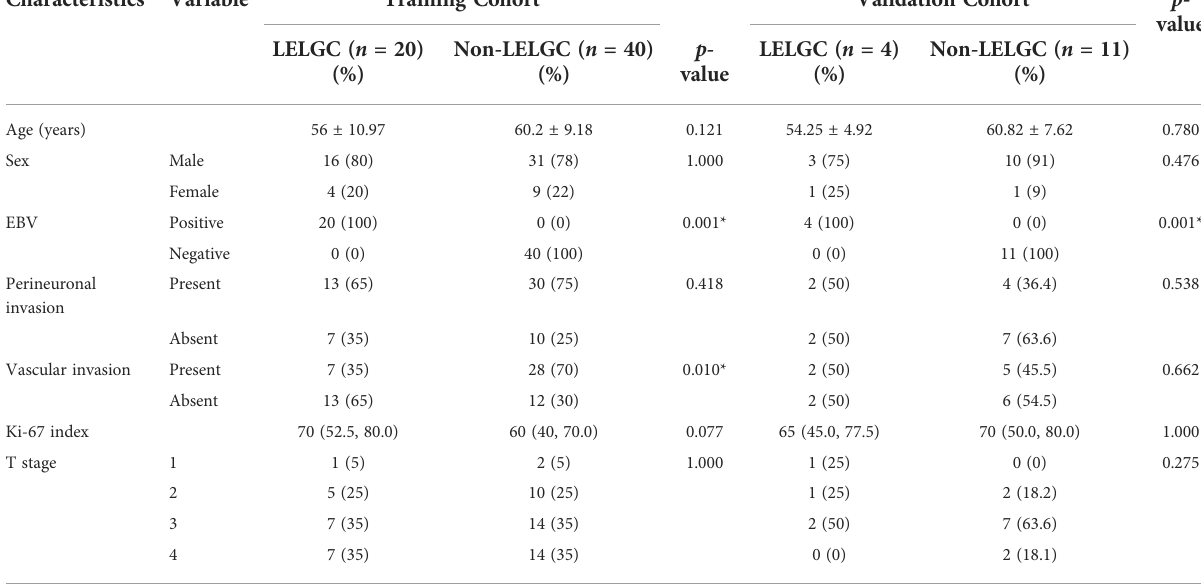
TABLE 1 Univariate analysis of clinicopathological characteristics in patients. Characteristics